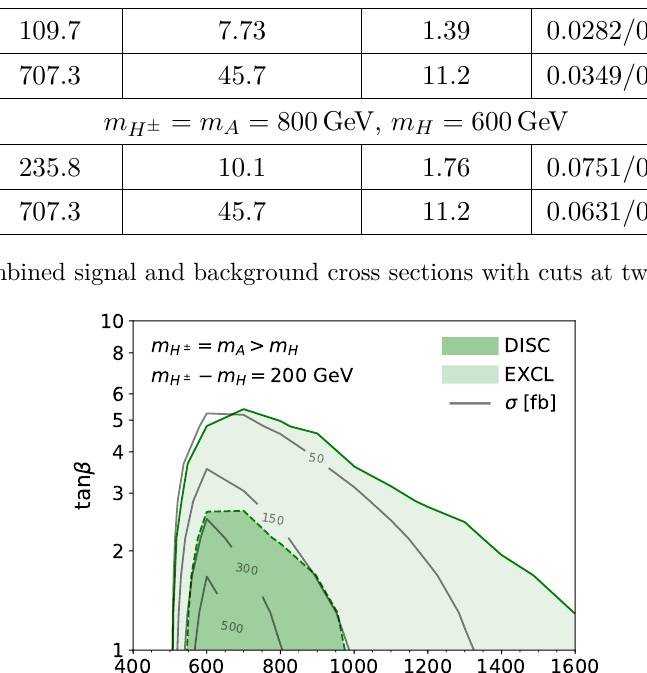
vs. tan β plane, for H ±